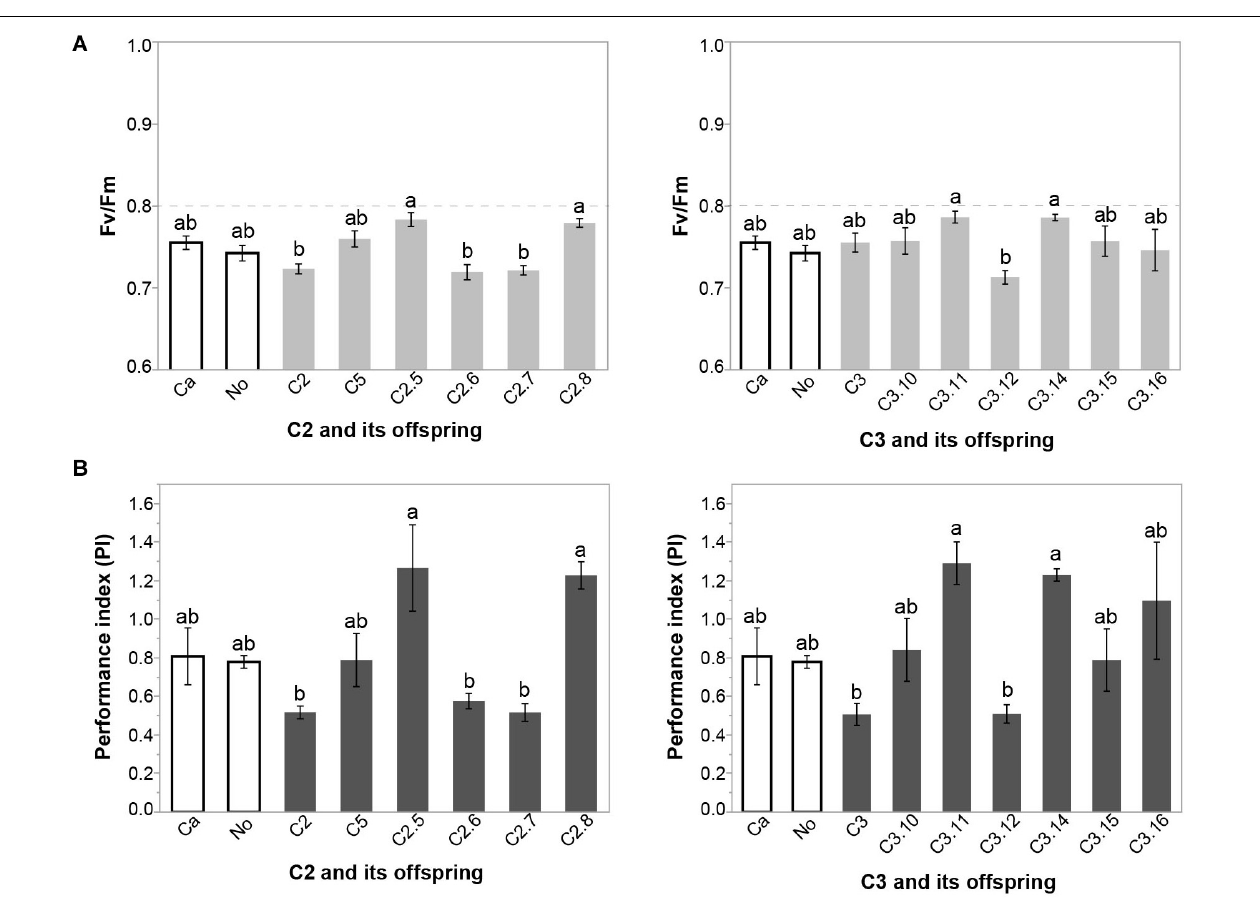
FIGURE 2 | Effect of inoculation with parental isolates C2 and C3 and their SSL progeny on (A) maximum quantum yield of PSII (F v /F m ) (B) performance index (PI) of cassava at 210 DAP in Experiment 1. Error bars represent ± S.E. Different letters above bars represent significant differences at p < 0.05 according to a Tukey post-hoc